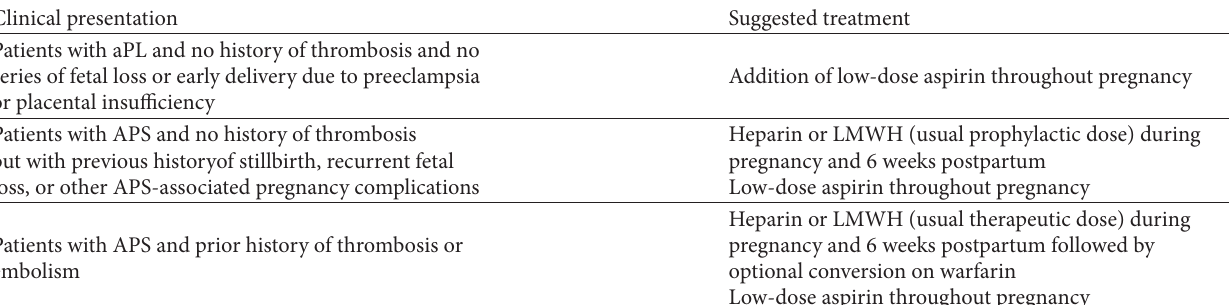
Table 1: Treatment of anti-phospholipid antibodies in